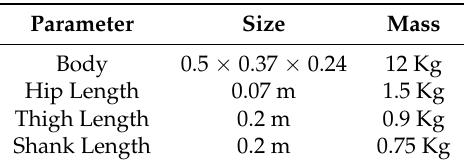
Table 1. Physical Robot Parameters.